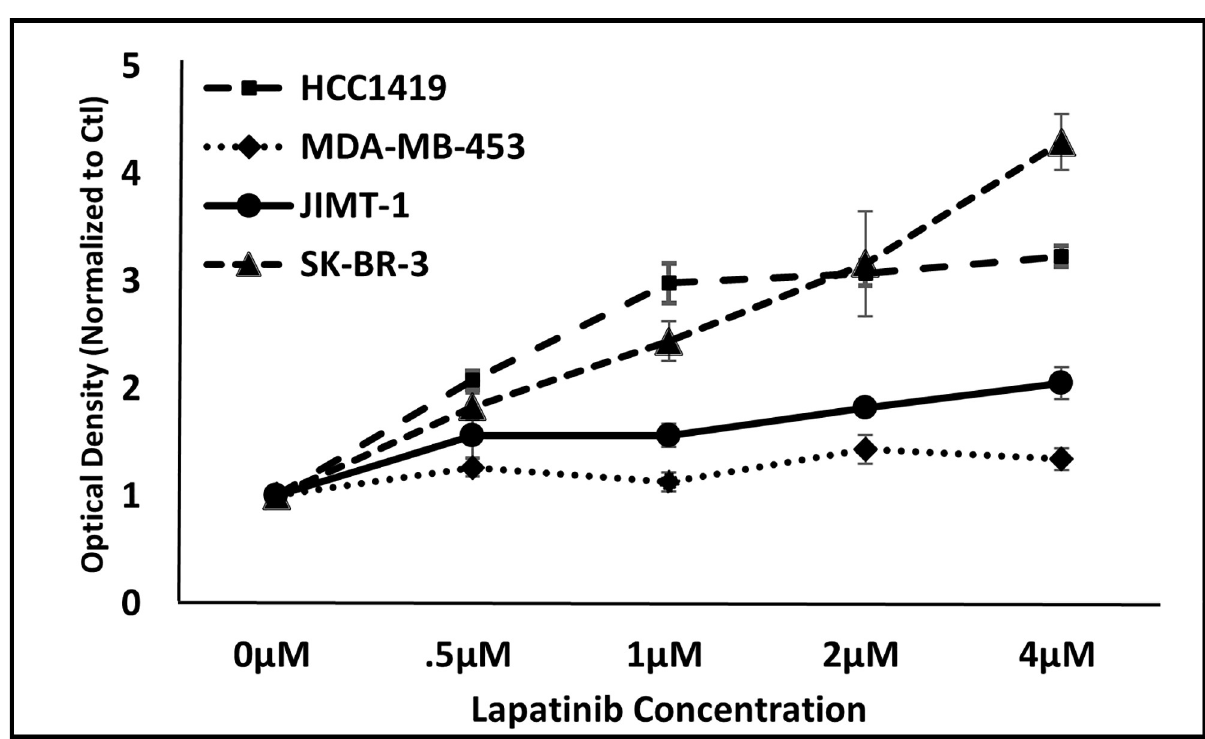
Fig 5. JIMT-1 and MDA-MB-453 cell lines display relative resistance to lapatinib. Cultured SK-BR-3, JIMT-1, HCC1419, and MDA-MB-453 cells were treated with increasing concentrations of lapatinib (0–4 μ M). After 72 hours incubation, resazurin sodium salt (Alamar Blue dye) was added to each well and further incubated until color change was noted, and optical densities of supernatants read spectrophotometrically at 630nM. Shown are composite data from at least three trials per cell line expressed as mean optical density +/- SEM.